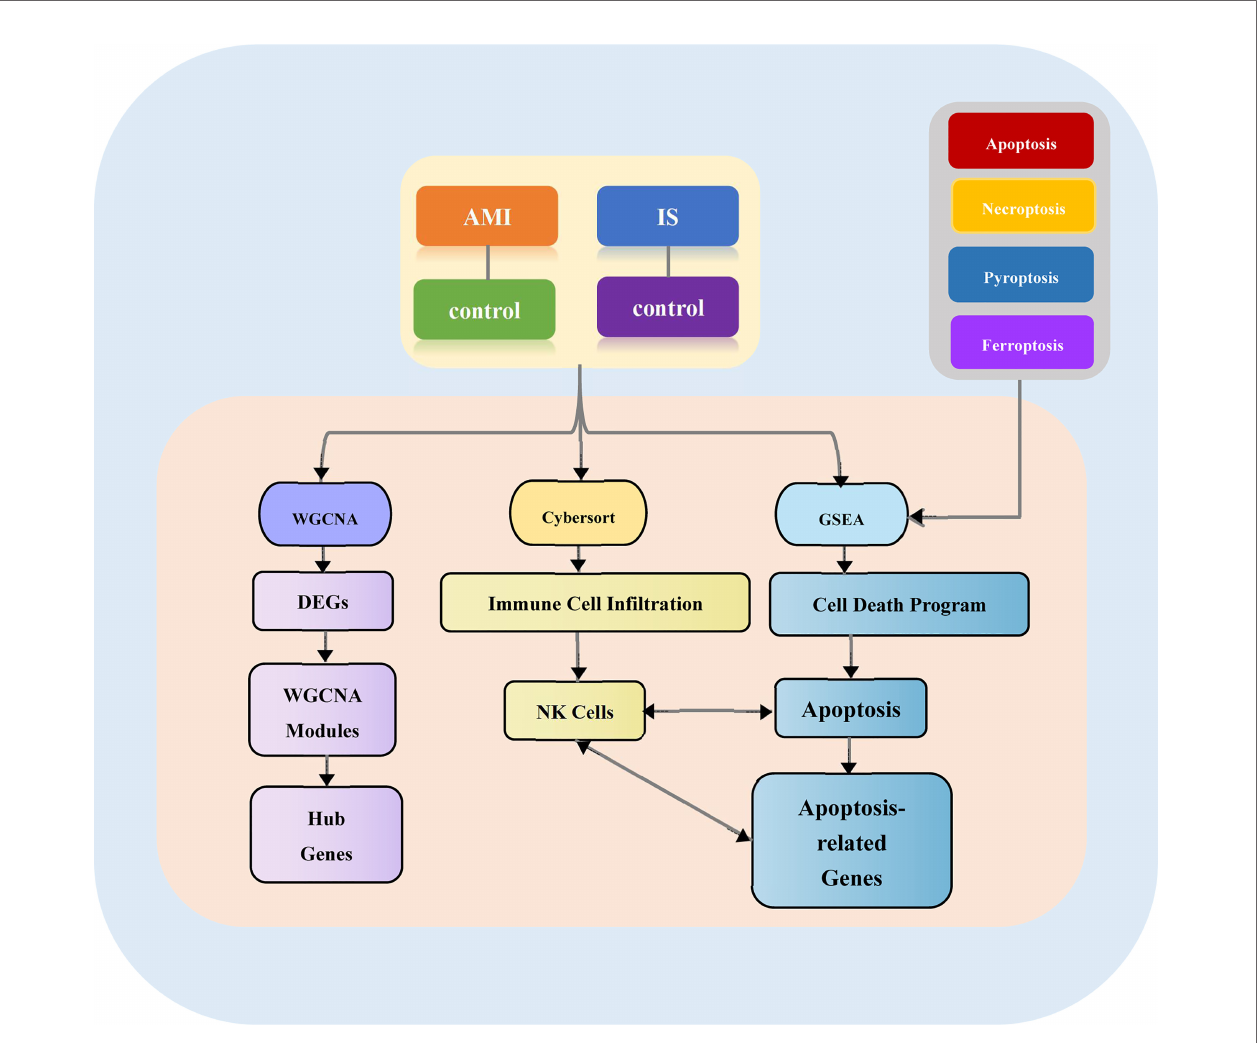
FIGURE 1 | Study fl owchart. AMI, acute myocardial infarction; DEGs, differentially expressed genes; WGCNA, weighted gene co-expression network analysis; GSEA, gene set enrichment analysis; NK cells, natural killer